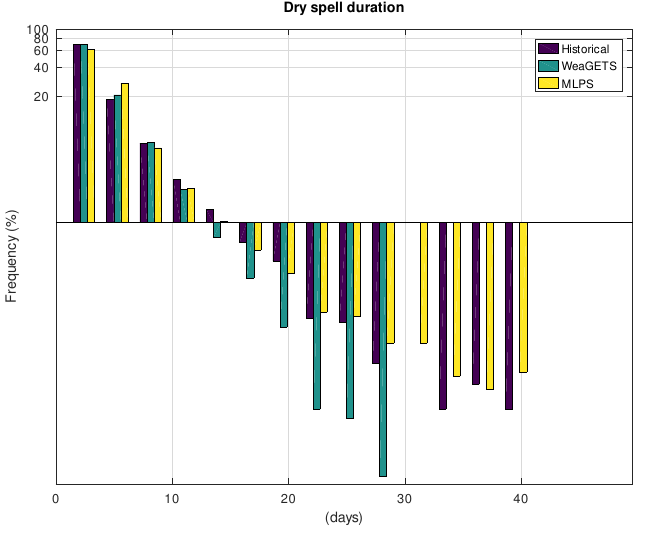
Figure 7. Histogram of the duration of dry spells of daily synthetic time series (WeaGETS and MLPS) and historical values of the Hohenpeissenberg weather